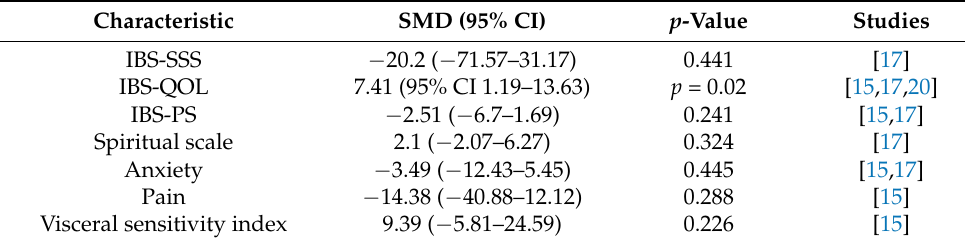
Table 1. Meta-analyses for follow-up observations comparing mindfulness with control.